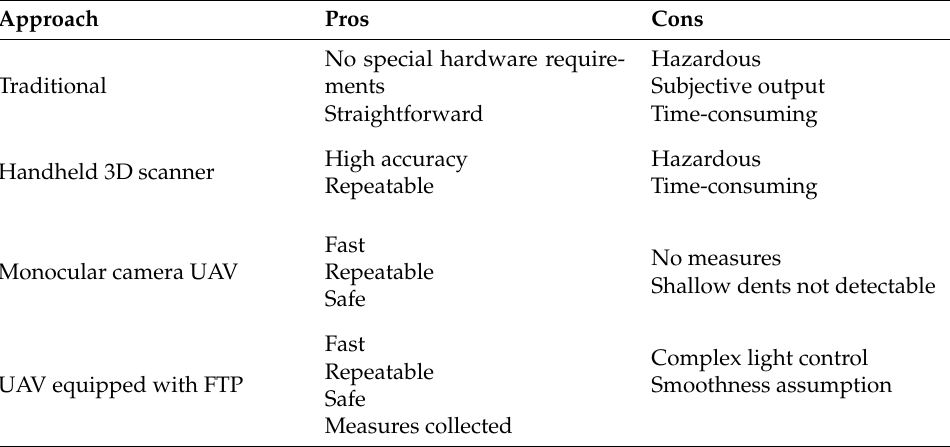
Table 7. Detection and measures of dents in MRO. Summary of pros and cons for different inspec- tion